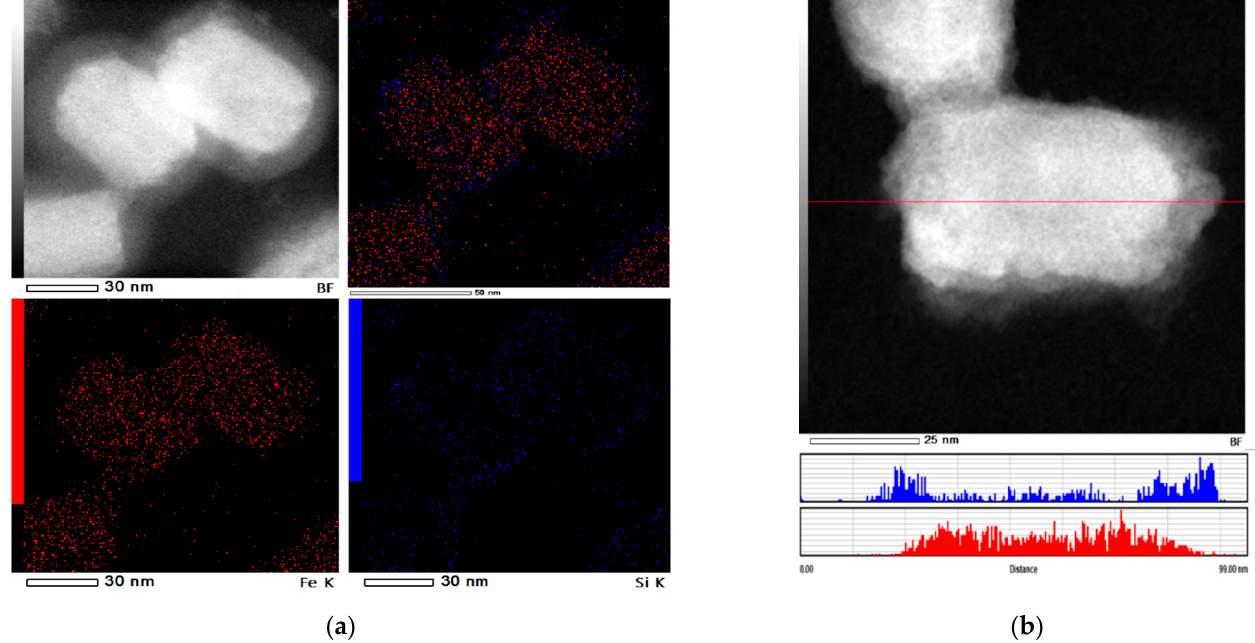
Figure 5. Bright-field HRSTEM images and the corresponding EDX elemental mapping images of the Fe (red), the Si (blue) and overlapped Fe and Si (a) and EDX distribution of Fe and Si along cross-section line (b) for core@shell nanoparticle sample 14.